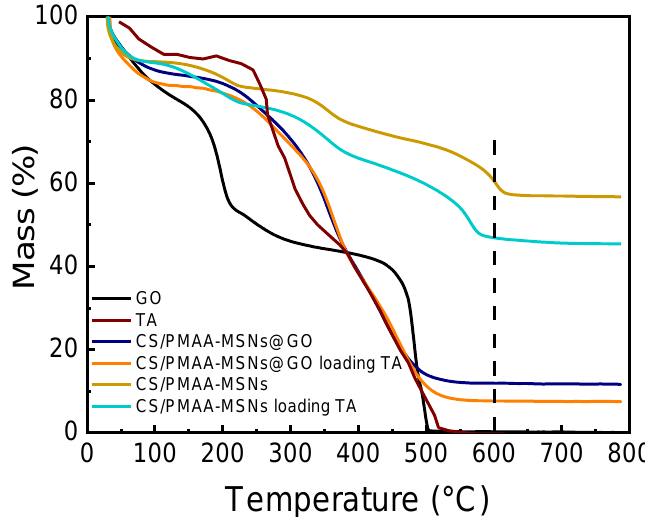
Figure 7. GO, TA, MSNs, MSN loading TA, CS/PAMAA-MSNs@GO, and CS/PMAA-MSNs@GO loading TA under air atmosphere heated from 30 to 800 °C.